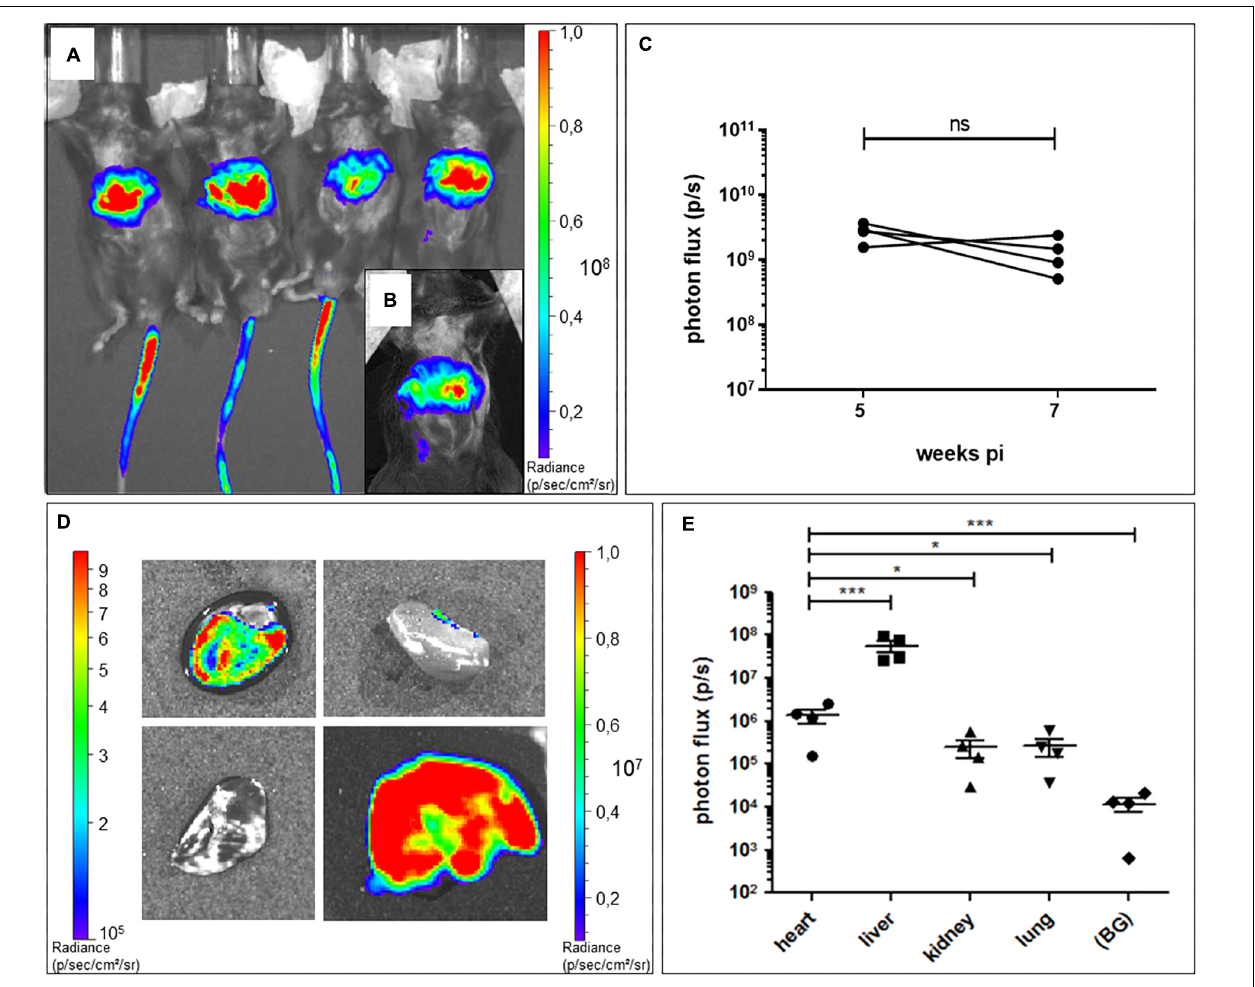
FIGURE 2 | Bioluminescence imaging of AAV2:9-mediated Luciferase-expression in heart and liver of WT mice. (A) In vivo bioluminescence imaging at 5 weeks and (B) 7 weeks post tail vein injection (pi) of AAV2/9_CMV-eGFP-T2A-fLuc-WPRE in WT mice. (C) In vivo ventral photon flux of the same mice at 5 and 7 weeks pi of AAV2/9_CMV-eGFP-T2A-fLuc-WPRE (WT+Luc: n = 4; Mann–Whitney test on log-transformed data) (D) Ex vivo bioluminescence imaging of isolated organs [heart (h) with apex pointing toward left bottom corner, kidney (k), lungs (lu), and liver (li)] of a representative mouse at 7 weeks pi. Note the different luminescence scale for the liver (right scale) compared to the other organs (left scale). (E) Ex vivo bioluminescence signal intensity of isolated organs at 7 weeks pi (WT+Luc: n = 4; repeated measures ANOVA followed by a Dunn’s test on the log-transformed data, ∗ p < 0.05, ∗∗∗ p <